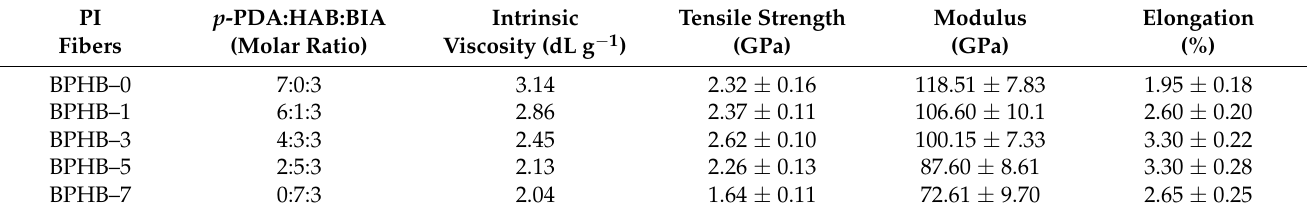
Table 1. Intrinsic viscosities of the PAA solutions and the mechanical properties of corresponding PI